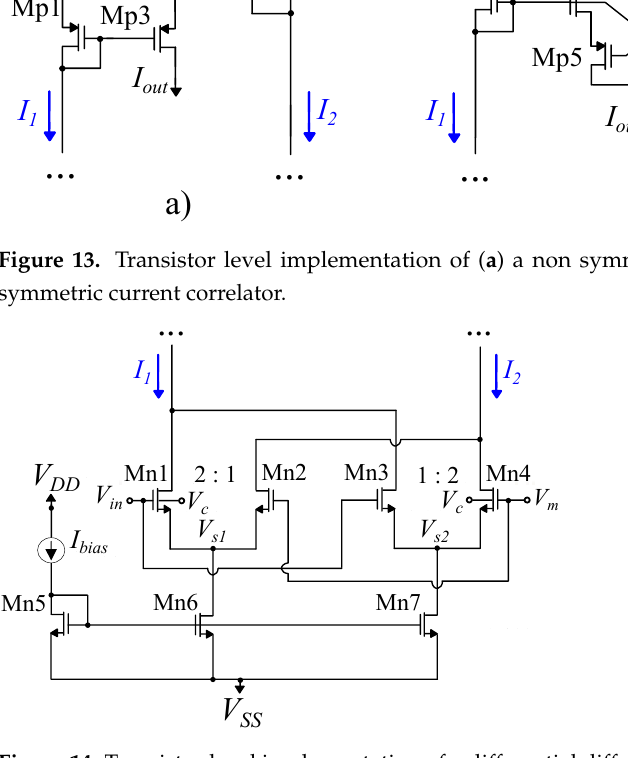
Figure 14. Transistor level implementation of a differential difference block.